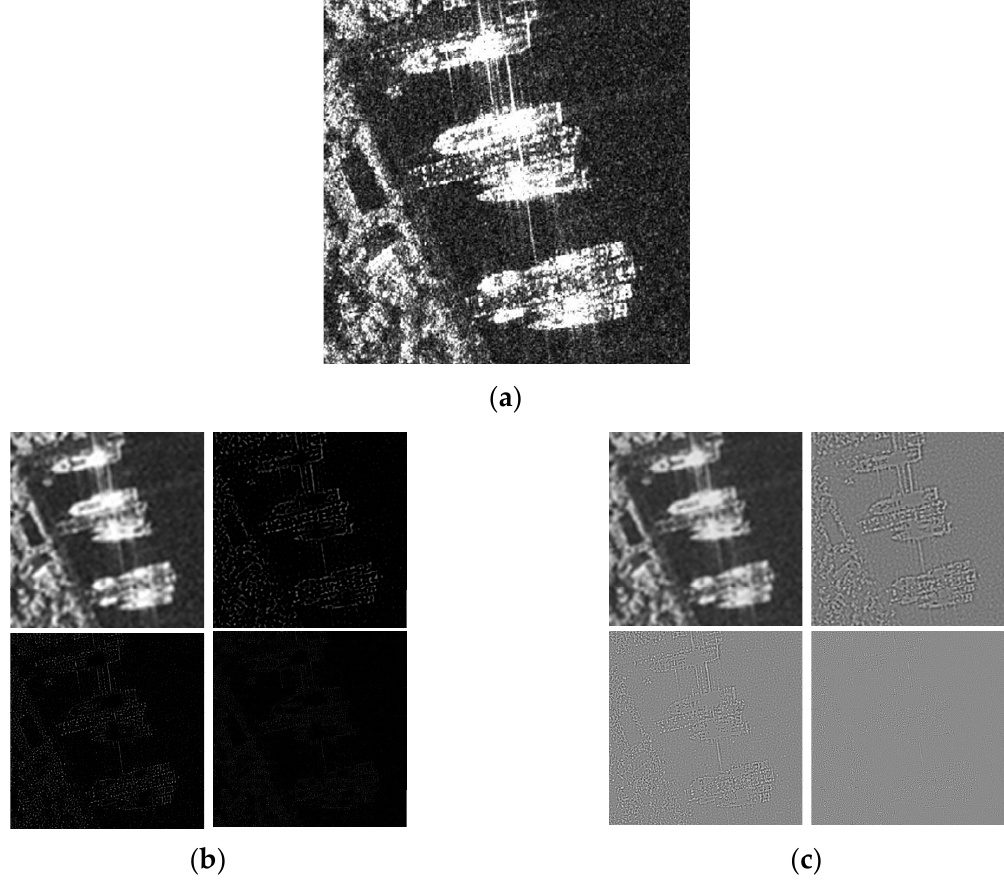
Figure 4. Example of Synthetic Aperture Radar Ship Detection Dataset (SSDD) Synthetic Aperture Radar (SAR) images ( a ) Original image ( b ) and subbands after NSLP ( c ) Normalized subbands after NSLP.